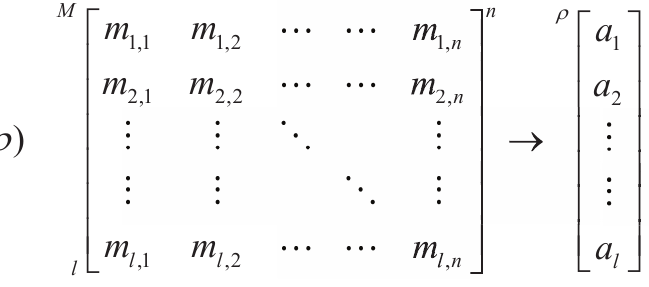
Figure 1. The LSSS access